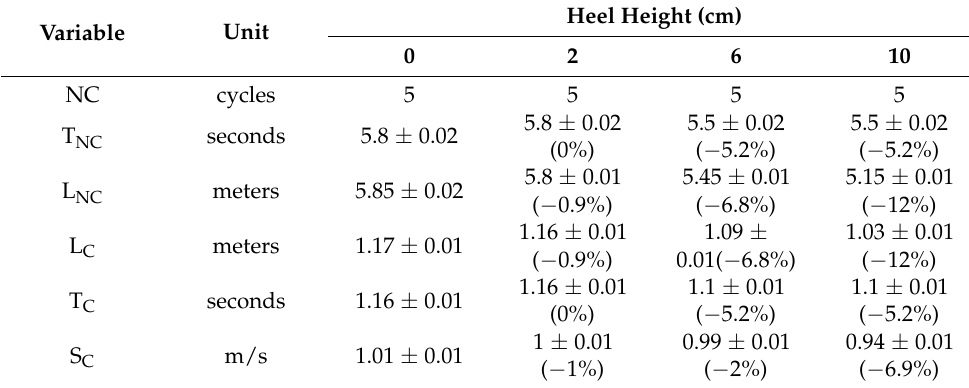
Table 1. The average results for the spatio-temporal variables. NC: number of cycles; T NC : time to complete NC cycles; L NC : distance covered in NC cycles; L C : gait cycle length; T C : time spent doing a full cycle; S C : speed.